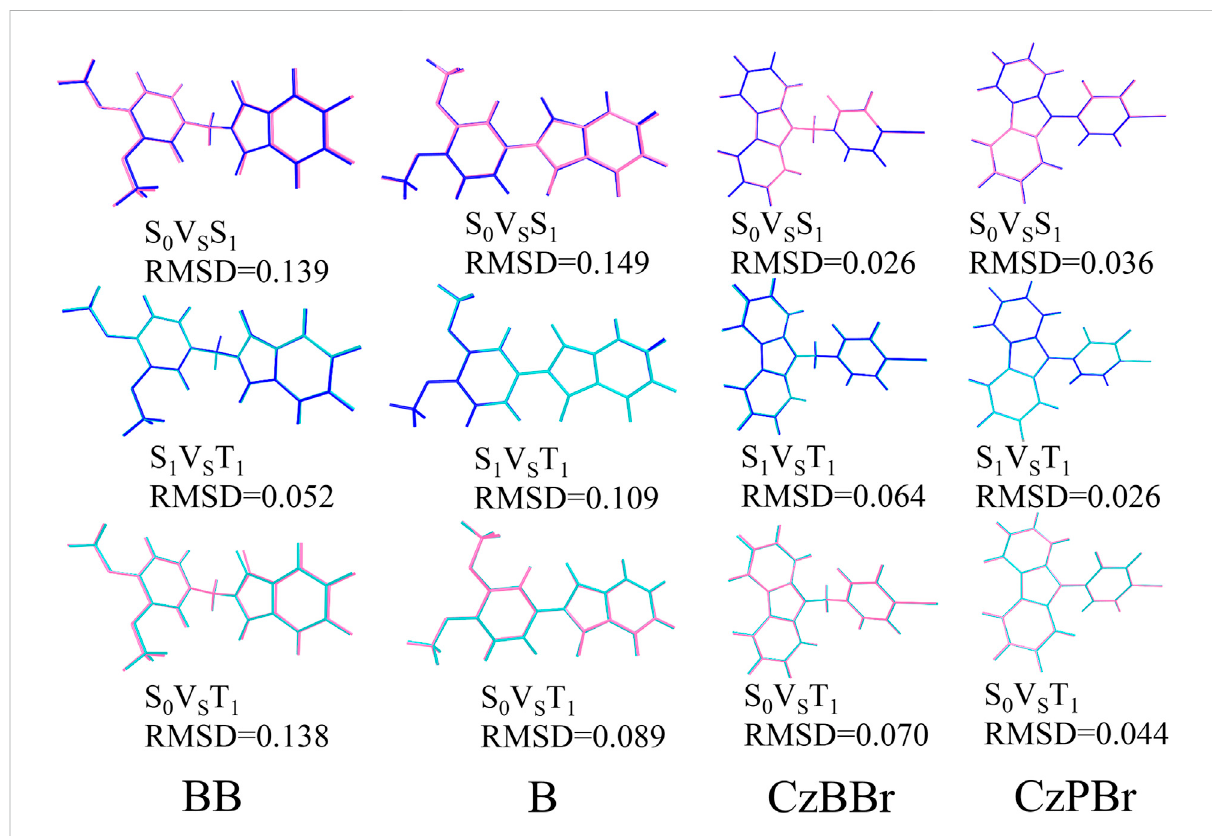
FIGURE 2 Comparison of S state and T state geometry, RMSD values of the studied